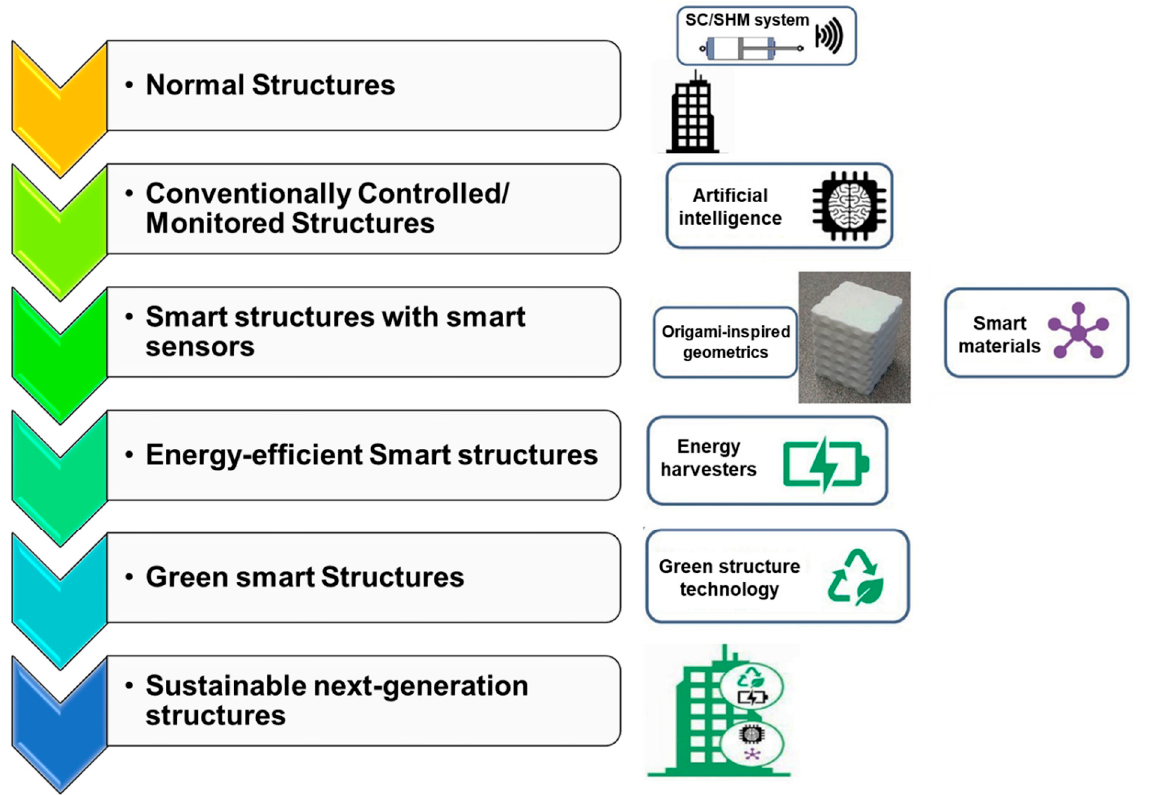
Figure 1. The main stages of typical integrating structural control and health monitoring systems.